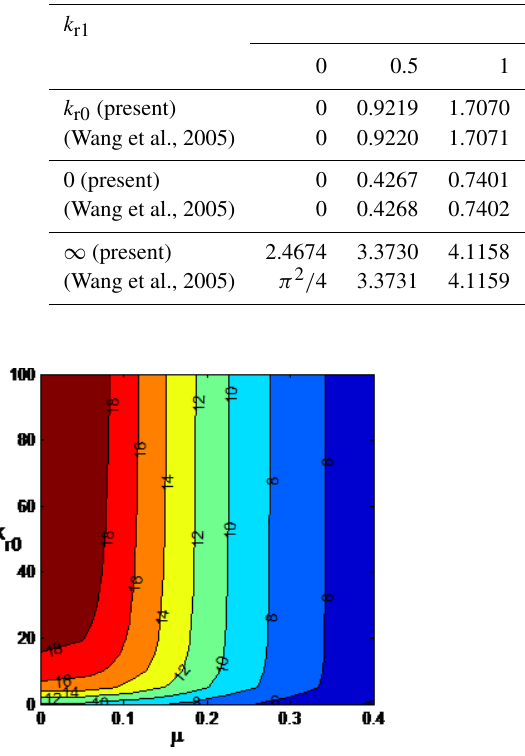
Figure 2. Contour plot of the buckling load p ( q = 0) with respect to µ and k r0 for k r1 = 0, k t = 10 8 (SS at x = L ).